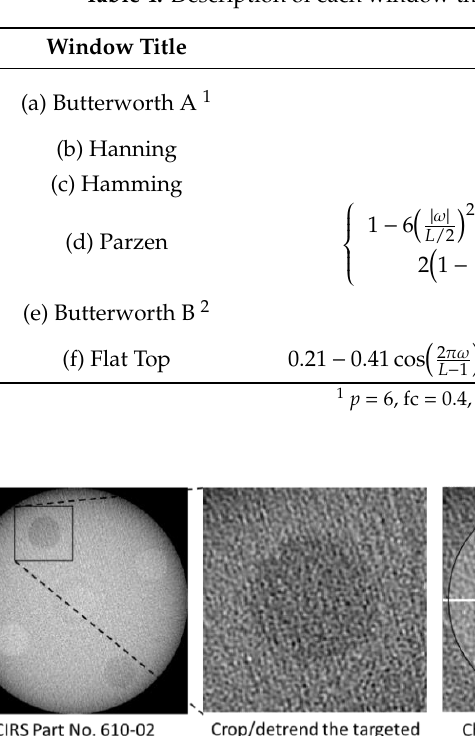
Table 4. Description of each window that was implemented with the ramp filter.